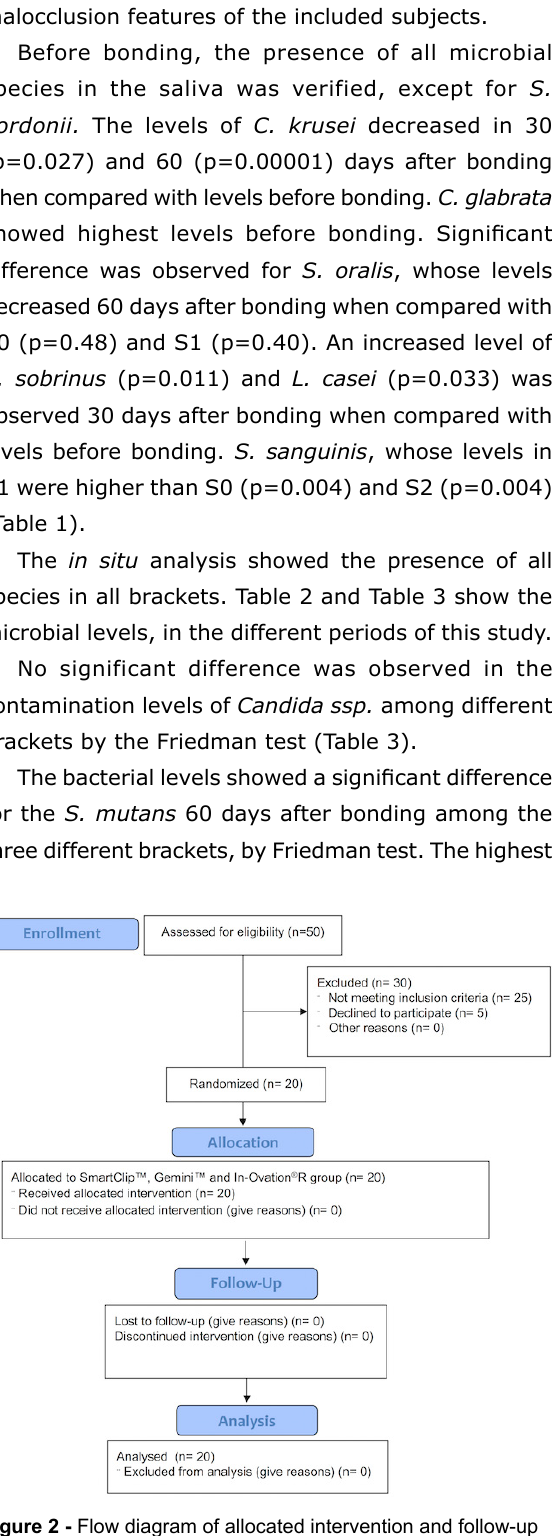
Figure 2 - Flow diagram of allocated intervention and